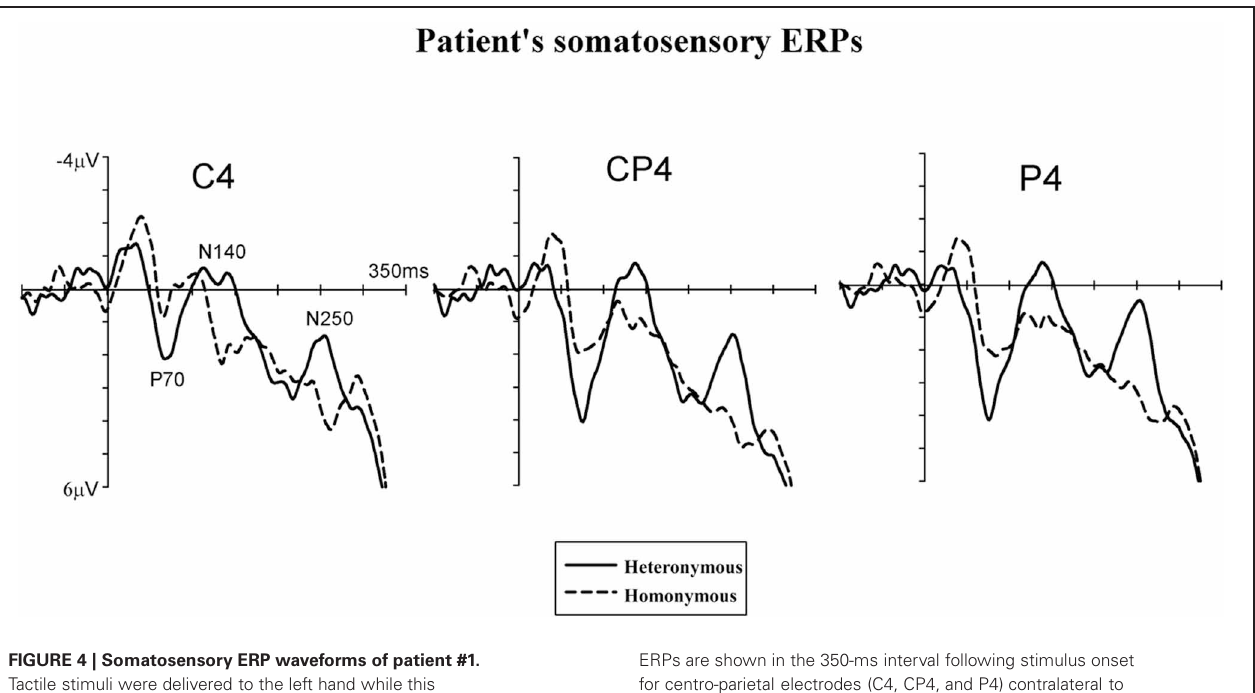
FIGURE 4 | Somatosensory ERP waveforms of patient #1. Tactile stimuli were delivered to the left hand while this hand was placed in the right, heteronymous hemi-space ( solid lines ) and in the left, homonymous hemi-space ( dashed lines ).